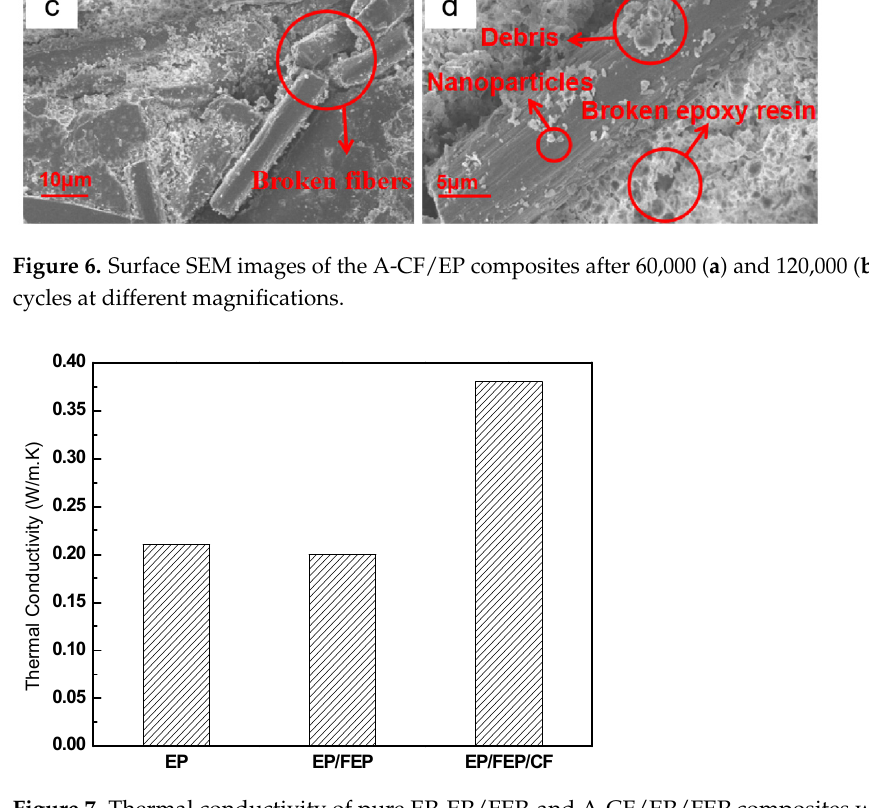
Figure 7. Thermal conductivity of pure EP, EP/FEP, and A-CF/EP/FEP composites with 20% FEP and 4% PU.